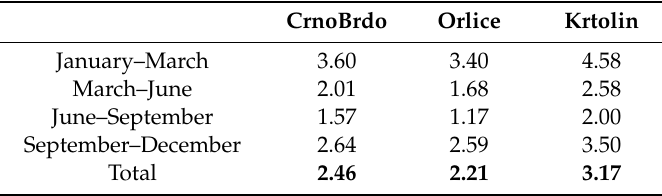
Figure 4. Analyzed power transmission system. Table 3. Wind farms–average power during the year